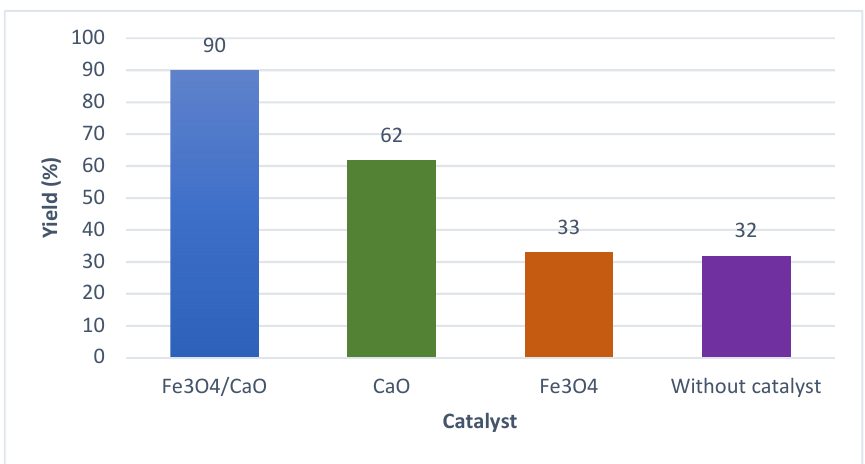
Figure 4. The biodiesel yield produced from palm oil off-grade catalyzed by Fe 3 O 4 /CaO, CaO, Fe 3 O 4 , and without catalyst.